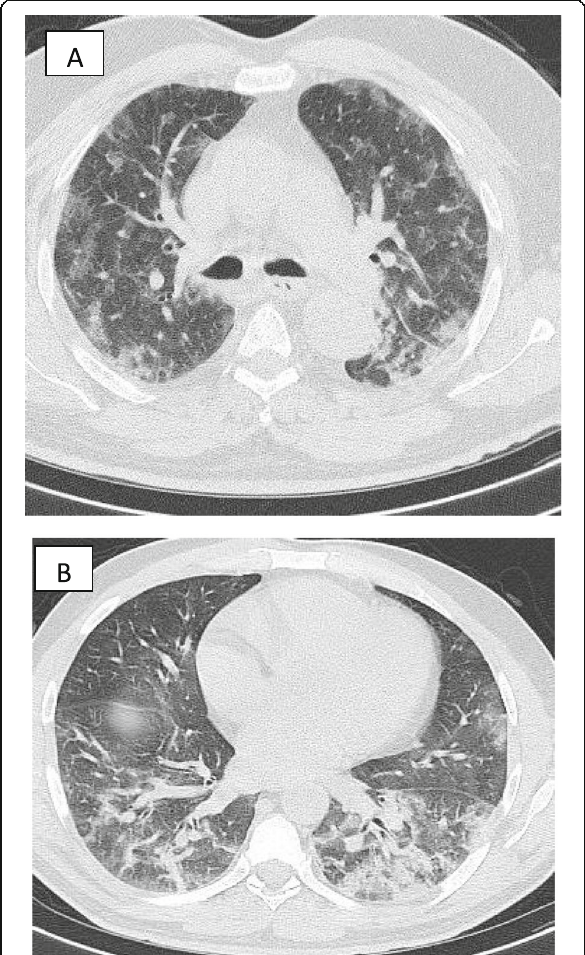
Fig. 2 Two different cases with bilateral multiple patches of ground glass infiltration and subsegmental consolidation, lesions mainly peripheral and